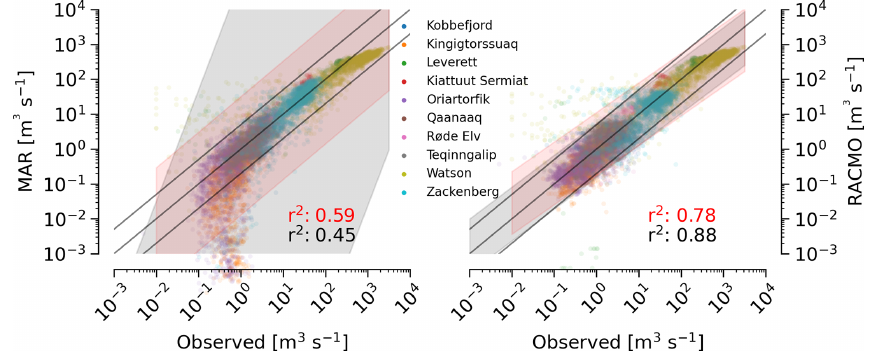
Figure 3. Bulk observation vs. RCM scatter plots. Daily runoff vs. observations for 10 outlets and a total of 15778d. Solid lines show 1 : 1 (center), 1 : 5 (upper), and 5 : 1 (lower). Grey band shows 5% to 95% prediction interval. Red band shows 5% to 95% prediction interval when removing the GEM stations near Nuuk (Table 1) that have small glaciers not included in the RCMs (5341d remain).